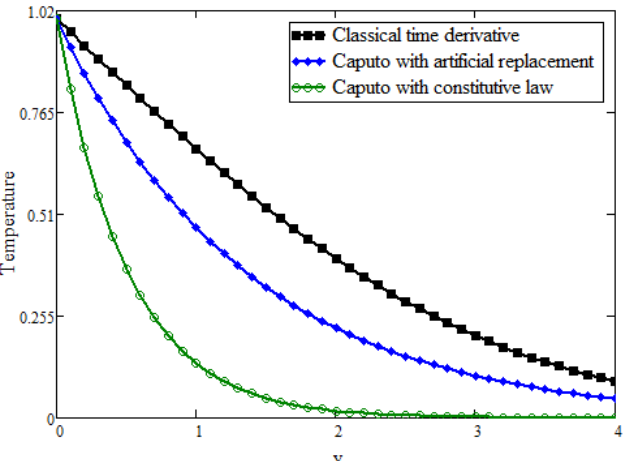
Figure 10. Comparison of temperature between classical time derivative, Caputo fractional model with artificial replacement and Caputo model with generalized constitutive law.